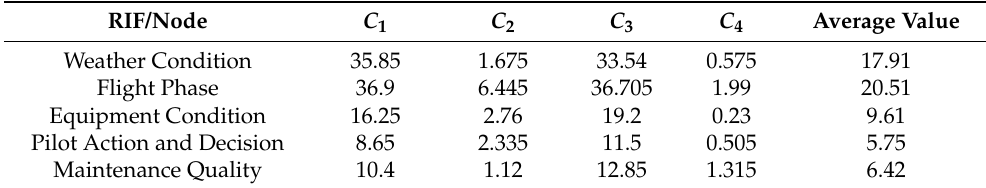
Table 5. The TRI of the five highest ranked risk factors for all casualty